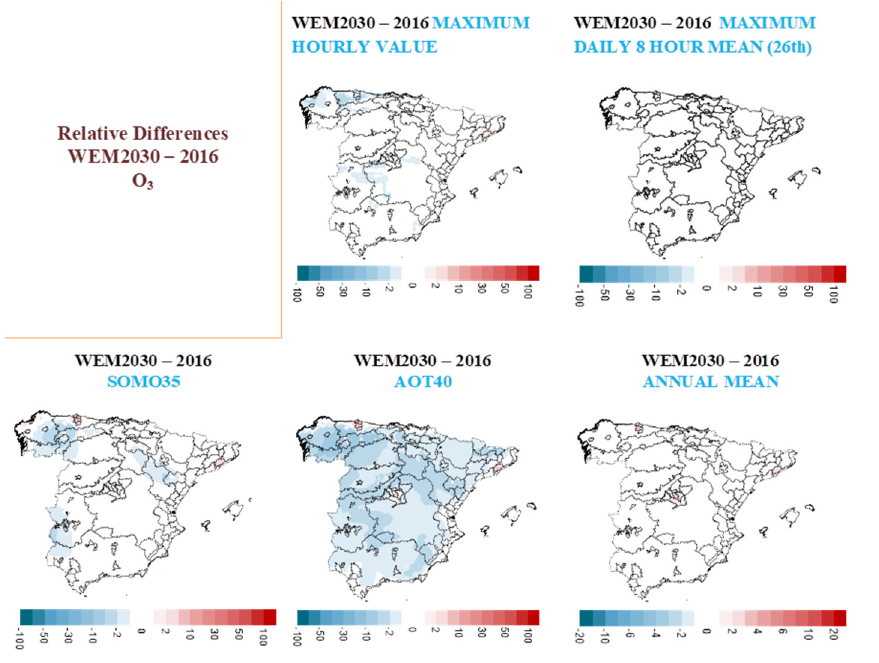
Figure 7. Relative difference (%) maps between the WEM2030 scenario and the reference case 2016 for different O 3 metrics.